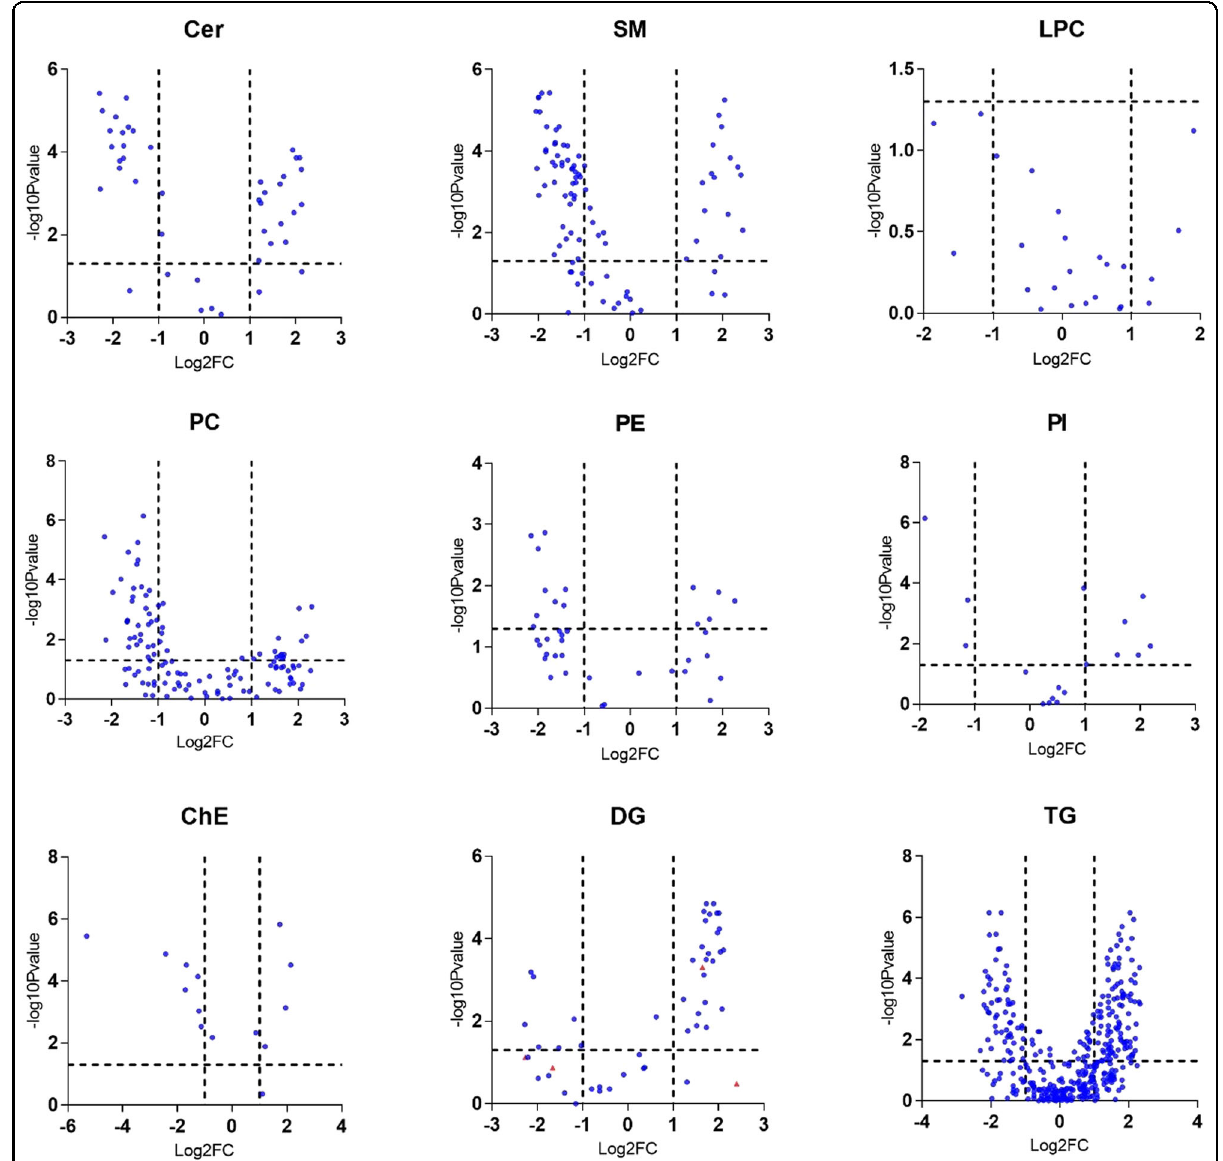
Fig. 2 Volcano plots showing signi fi cant lipid species in the nine separate lipid groups. Each dot on the plot is a single lipid species. Horizontal axis: fold change (in log2 scale); vertical axis: adjusted p -value (in log10 scale). Vertical dashed lines highlight log2 fold changes of − 1 and + 1, while a horizontal dashed line represents a p -value of 0.05. Cer ceramides, SM sphingomyelins, ChE Cholesteryl esters, DG diglycerides, TG triglycerides, PC phosphatidylcholines, LPC lyso- phosphatidylcholines, PE phosphatidylethanolamines, PI